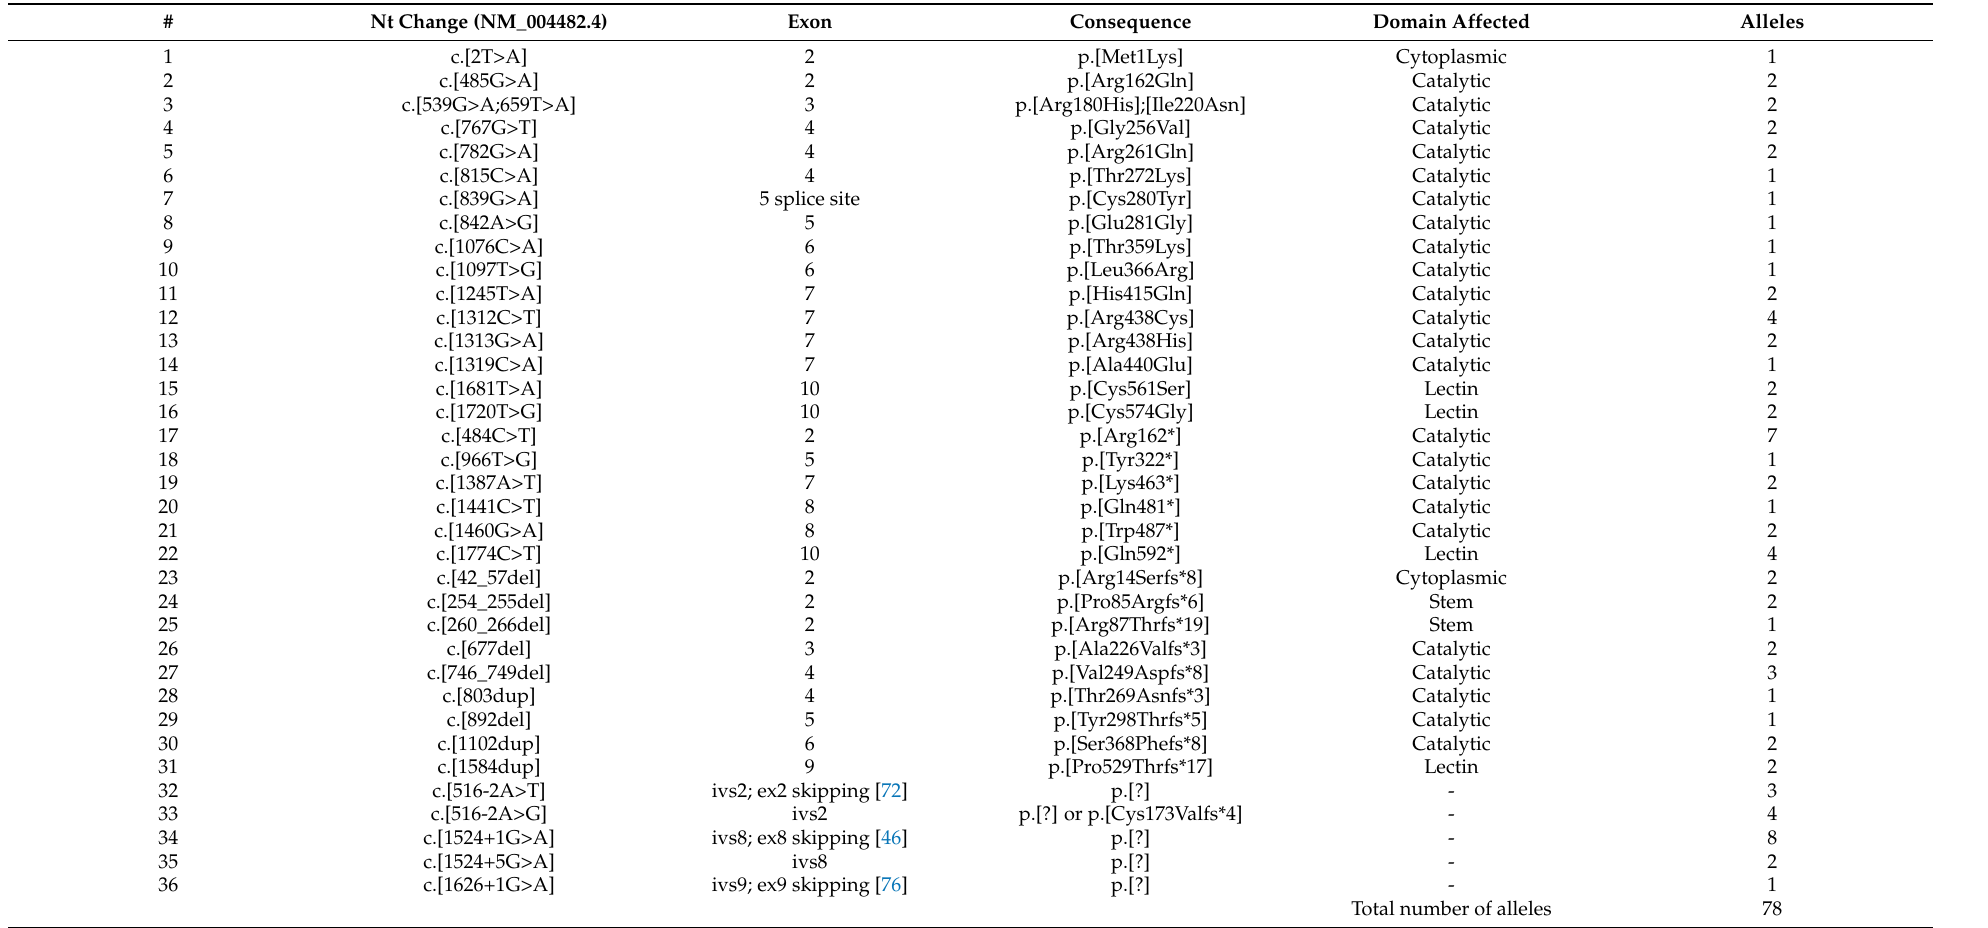
Table 3. GALNT3 mutations in HFTC and affected domains in